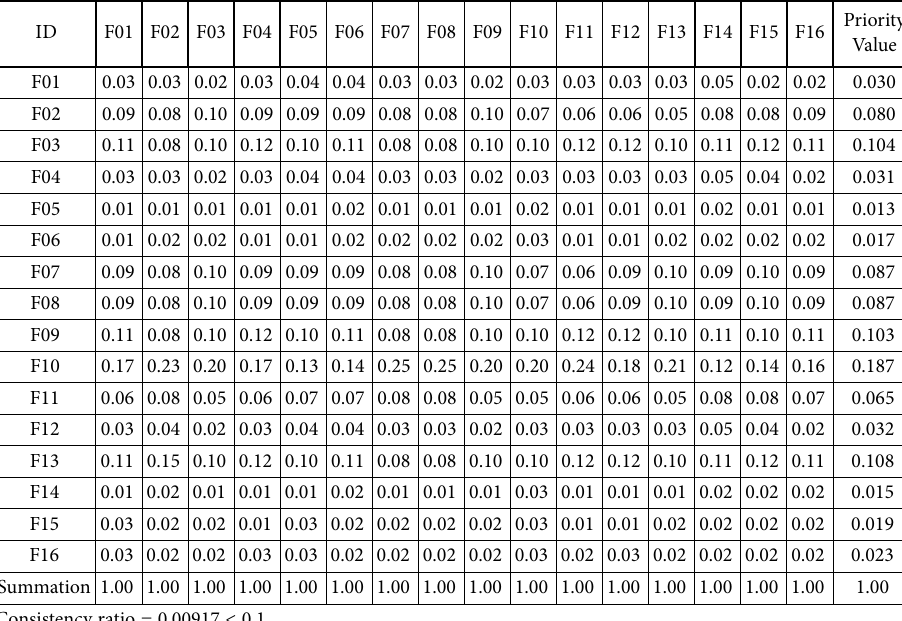
Table 6. Additional works − AHP normalized pairwise comparisons